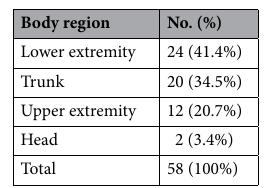
Table 2. Summary of injuries by body region.